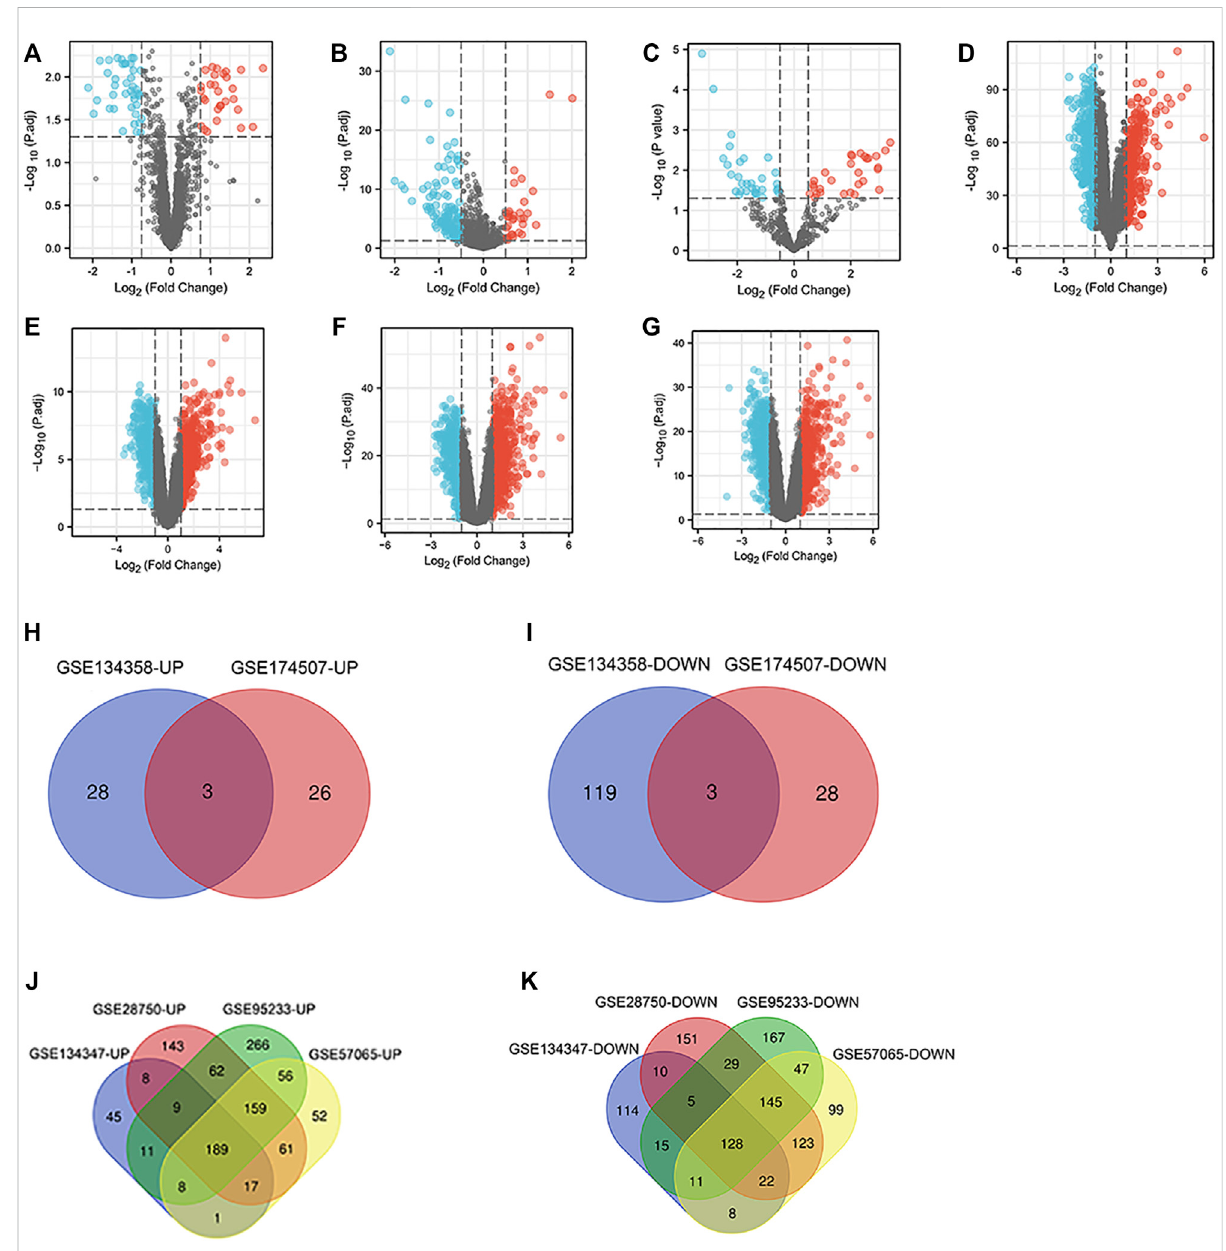
FIGURE 2 DElncRNAs, miRNAs and mRNAs between the sepsis and normal samples. (A) Volcano map of the GSE145227 dataset. (B) Volcano map of the GSE134358 dataset. (C) Volcano map of the GSE174507 dataset. (D) Volcano map of the GSE134347 dataset. (E) Volcano map of the GSE63492 dataset. (F) Volcano map of the GSE95233 dataset. (G) Volcano map of the GSE57065 dataset. Red spots represent upregulated genes, and blue spots represent downregulated genes in volcano maps. (H,I) Venn diagrams represent the intersections of upregulated and downregulated DEmiRNAs in the GSE134358 and GSE174507 datasets. (J,K) Venn diagrams represent the intersections of upregulated and downregulated DEmRNAs in the GSE134347, GSE63492, GSE95233 and GSE57065 datasets. DElncRNAs, differentially expressed lncRNAs; DEmiRNAs, differentially expressed miRNAs; DEmRNAs, differentially expressed